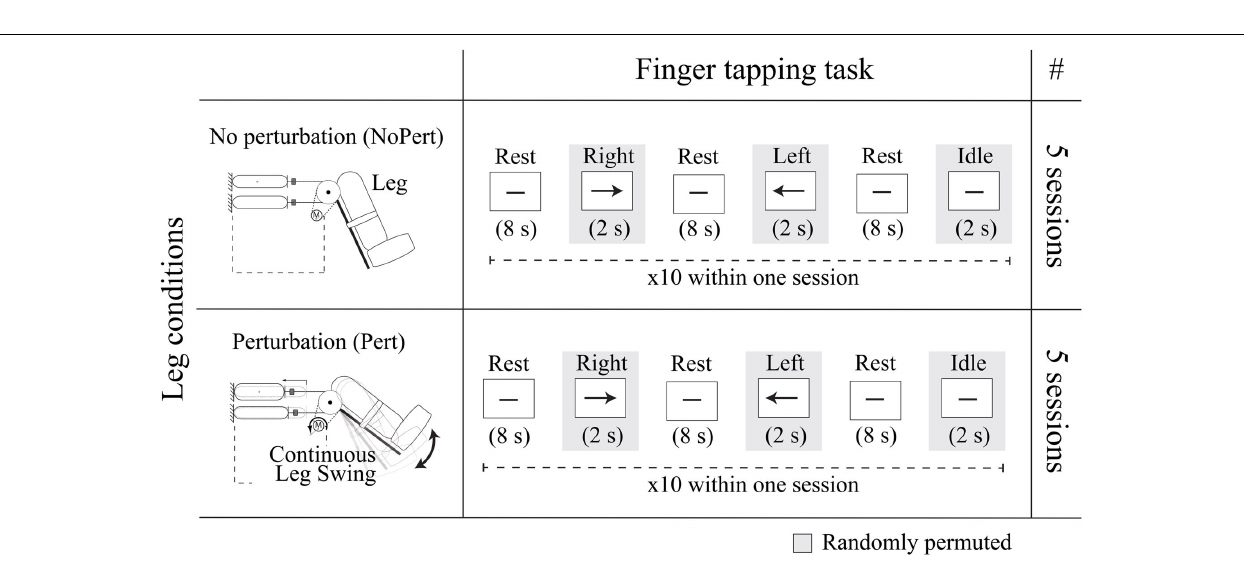
FIGURE 3 | Experimental design. The experiment is structured as a 3 × 2 factorial design, consisting of two factors “finger tapping task” and “leg condition.” The former is divided into three levels, being left hand finger tapping (Left), right hand finger tapping (Right) and Idle, whose temporal representation is visualized in the “Finger tapping task” column. The “leg